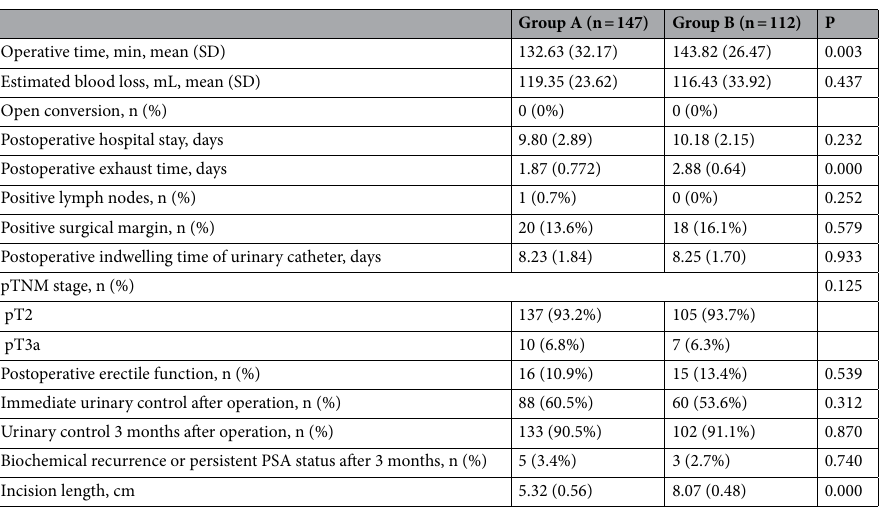
Table 2. Comparison of postoperative efficacy of patients (cases). A PSA above 0.2 ng/ml at 3 months postoperatively was defined as biochemical recurrence or persistent PSA status. Erectile function was defined as a patient’s postoperative IIEF scale score greater than 12 and most of the time being able to complete sexual life. SD standard